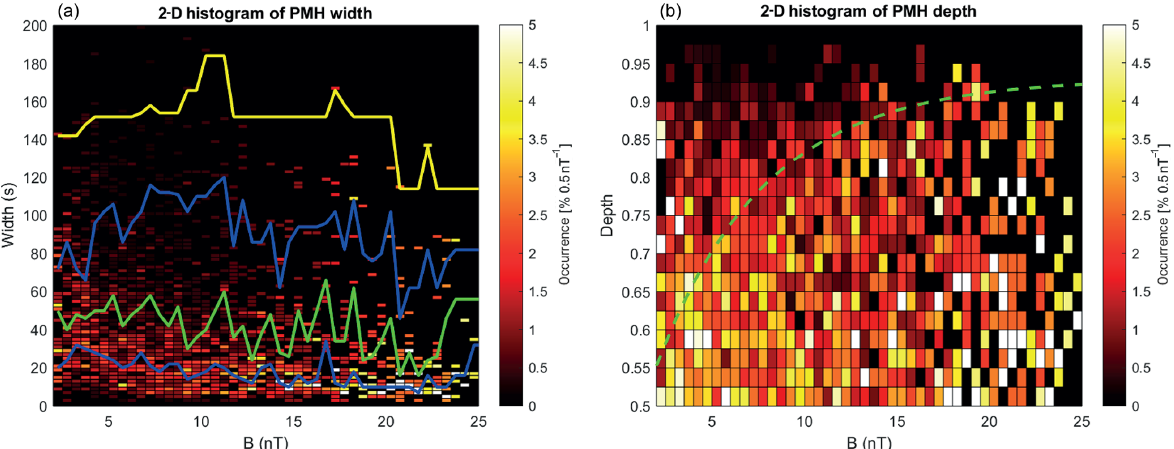
Figure 10. 2-D histogram of the occurrence rate of (a) the width (in seconds) and (b) the depth of the pseudo MHs as a function of the background magnetic field strength. In panel (a) the 25th (blue), 50th (green), 75th (blue), and 97.5th (yellow) percentiles are shown. In panel (b) the dashed green line is the exponential fit to the approximate upper boundary of the depth of the structures from the LHMs in Fig. 9.